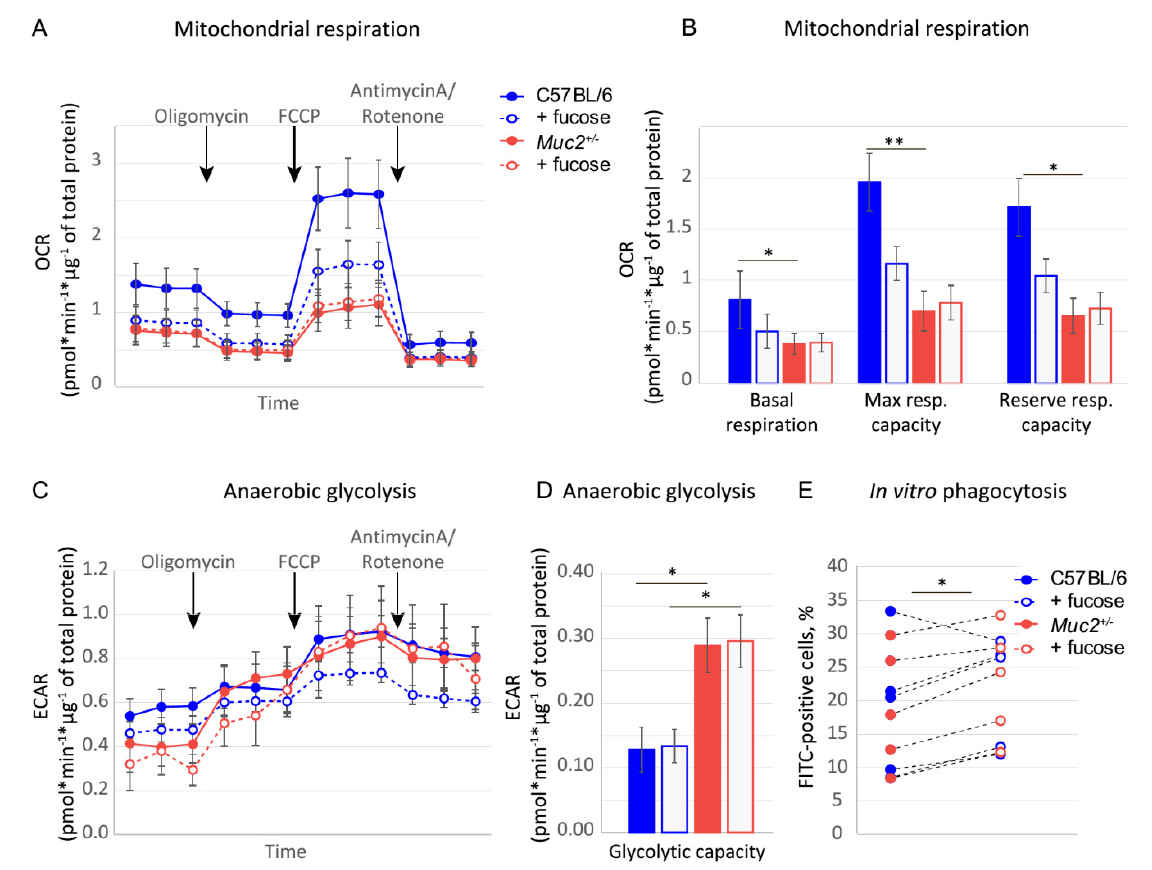
Figure 3. Energy metabolism and phagocytic activity in isolated peritoneal macrophages. ( A ). OCR was measured at basal level followed by the sequential treatment with oligomycin, FCCP, and a mixture of antimycin A and rotenone. Each data point represents average OCR per group per measurement. ( B ). Basal respiration, maximal, and reserve respiratory capacity. “C57BL/s” vs. “ Muc2 +/ − ”: * p < 0.05, ** p < 0.01, n = 5–6, Student’s t -test. ( C ). ECAR was measured at basal level followed by the sequential treatment with oligomycin, FCCP, and a mixture of antimycin A and rotenone. Each data point represents average ECAR per group per measurement. ( D ). Glycolytic capacity. “C57BL/s” vs. “ Muc2 +/ − “ : * p < 0.05, n = 5–6, Student’s t -test. ( E ). In vitro phagocytosis of peritoneal macrophages, percentage of cells that captured fluorescent particles. “Fucose” vs. “Control”: * p < 0.05, N = 11 in each group, paired Student’s t